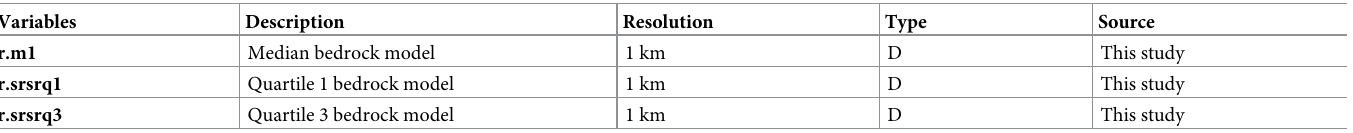
Table 1. List of bedrock model outputs from [15] used in the regression. D = discrete.